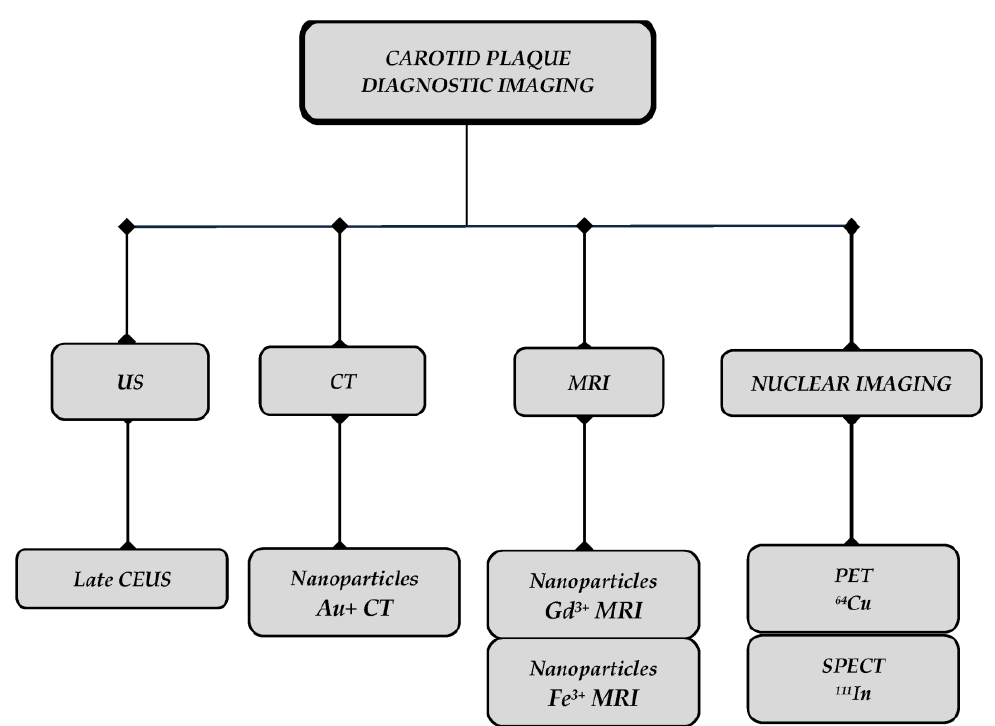
Figure 1. A step-wise approach to atherosclerotic plaque identification and characterization. Diagnosis and characterization of atherosclerotic plaque requires the employment of diagnostic image techniques. Among these, a first-line approach is represented by Doppler ultrasound, following CT and MRI scans. Recently, other techniques have been proposed to improve diagnosis and, mainly, identification of plaque features which could be predictive of its vulnerability and hence patient outcome. These techniques investigate plaque’s molecular composition and are focused on detecting its inflammatory elements and targeting antigen overexpression, thus amplifying diagnostic potential at our disposal. US, ultrasonography; CT, computed tomography; MRI, magnetic resonance imaging; PET, positron emission tomography; SPECT, single photon emission computed tomography; CEUS.